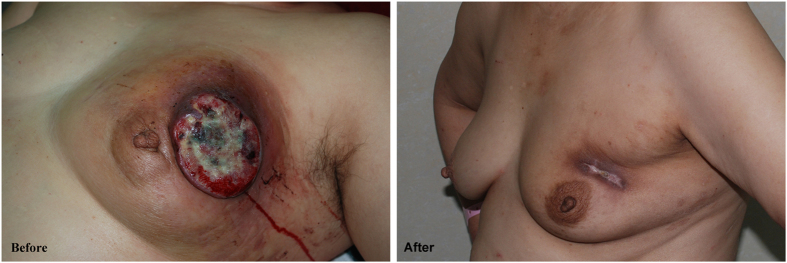
Before: Before chemotherapy, the tumor was complicated with regional ulceration and infection, and surgery was difficult. After: Ulcer healed and edema subsided after 5 cycles of primary FEC chemotherapy.